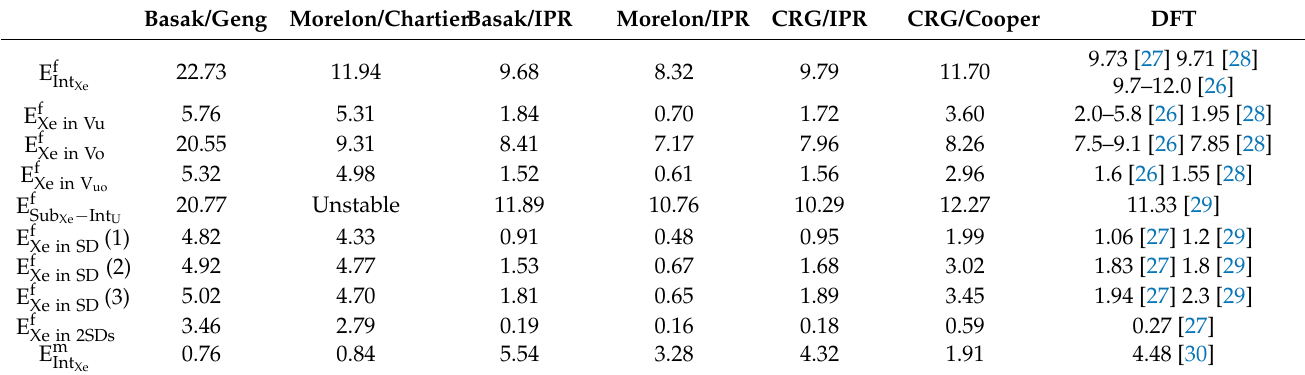
Table 1. Comparison of energy of xenon (Xe) point defects in uranium dioxide (UO 2 ) bulk calculated using various interatomic potentials at 0 K. Charge corrections for charge defects were not considered in the calculations